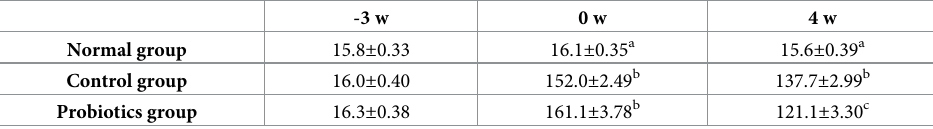
Table 11. The effect of probiotics treatment on serum blood urea nitrogen concentration (mg/dL) in adenine- induced CKD